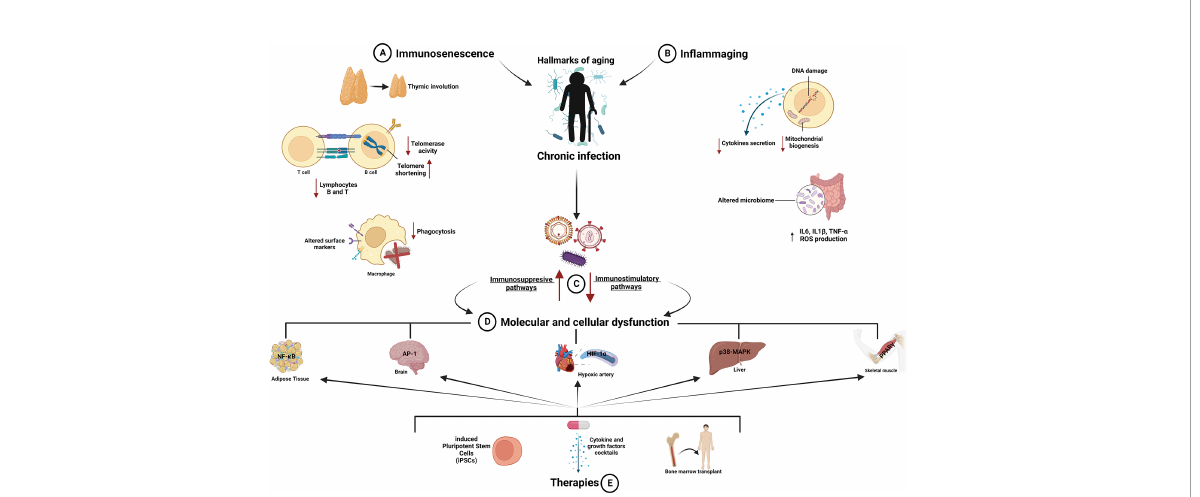
FIGURE 1 Aging of the immune system: mechanisms and therapeutic strategies. (A, B) The immune system declines during aging, and its exposure to pathogens induces overstimulation and overreaction of immune cells (macrophages; lymphocytes B and T; natural killer and dendritic cells), releasing chemical mediators that affect their function and driving them toward immunosenescence and in fl ammaging. These processes accelerate the onset of age-related diseases reducing health span. (C) Aging alters immunity provoking unbalance between immunostimulatory and immunosuppressive mechanisms, which in turn impairs relevant functions of the immune system, including thymic involution, altered surface markers and phagocytosis of macrophages, decreased number and activity of B and T lymphocytes, telomerase shortening and DNA damage, reduced cytokine secretion, decreased mitochondrial biogenesis, and elevated ROS level. (D) All these changes ultimately cause dysfunction in different tissues and systems such as adipose, hepatic, and skeletal muscle tissues and cardiovascular and nervous systems. (E) Therapeutic strategies aimed to rejuvenate the immune system and decrease the risk of infectious diseases in elderly people are depicted. AP-1, activator protein 1; HIF-1 a , hypoxia-inducible factor 1; IL1 b , interleukin-1 b ; IL6, interleukin-6; NF- k B, nuclear factor kappa B; p38-MAPK, p38-mitogen activated protein kinase; PPAR- g , peroxisome proliferator- activated receptor gamma; TNF- a , tumor necrosis factor-alpha. Created with